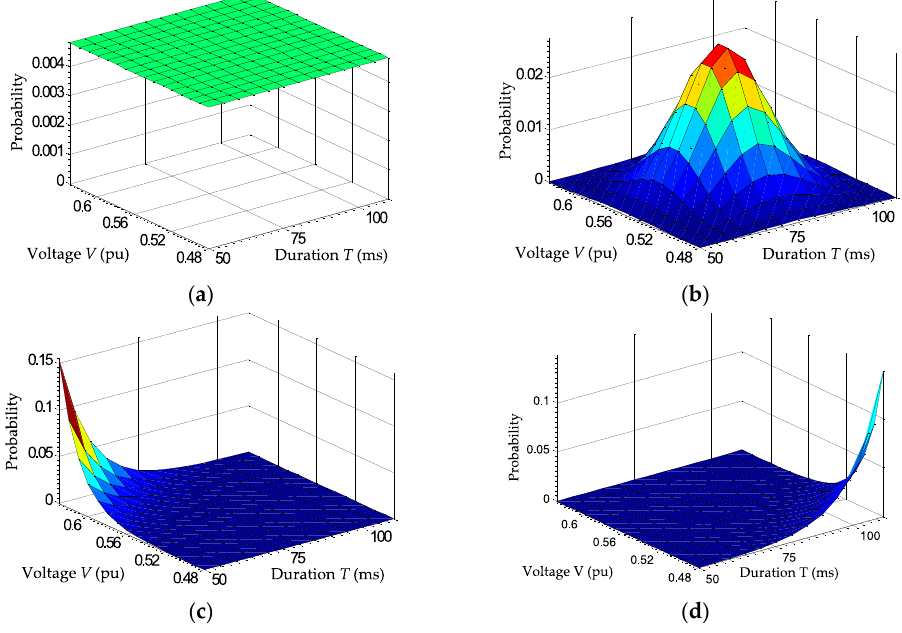
Figure 13. Probability of occurrence for voltage–tolerance characteristics for PC with assuming various density functions: ( a ) uniform; ( b ) normal; ( c ) exponential and ( d ) reverse exponential. Energies 2017 , 10 , 401